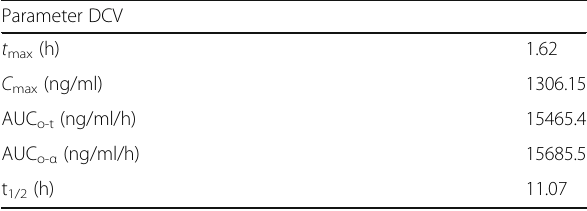
Additional file 1: Figure S1. The schematic diagram showing the IL-DLLME process of daclatasvir from rat serum. Figure S2. The systematic predictable mechanism and its phase separation of IL from rat serum. Figure S3. Optimization of vortex-assisted an IL-based DLLME conditions. Table S1. Partition ratio and (%) recovery of daclatasvir a into IL. Table S2. Extraction recovery (ER) and enrichment factor (EF) of daclatasvir. Table S3. Intra- and inter-day assay variation data. (DOCX 6487 kb)